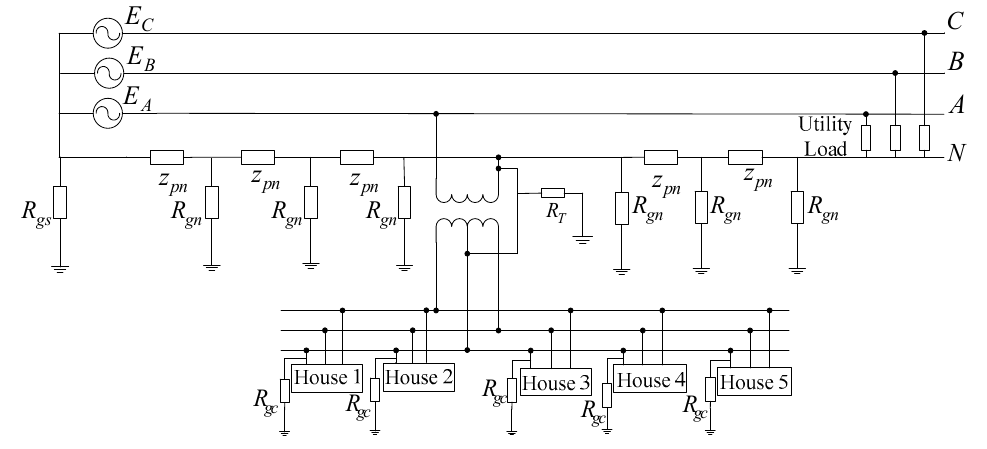
Figure 9. Single-line circuit for the typical MGN system.